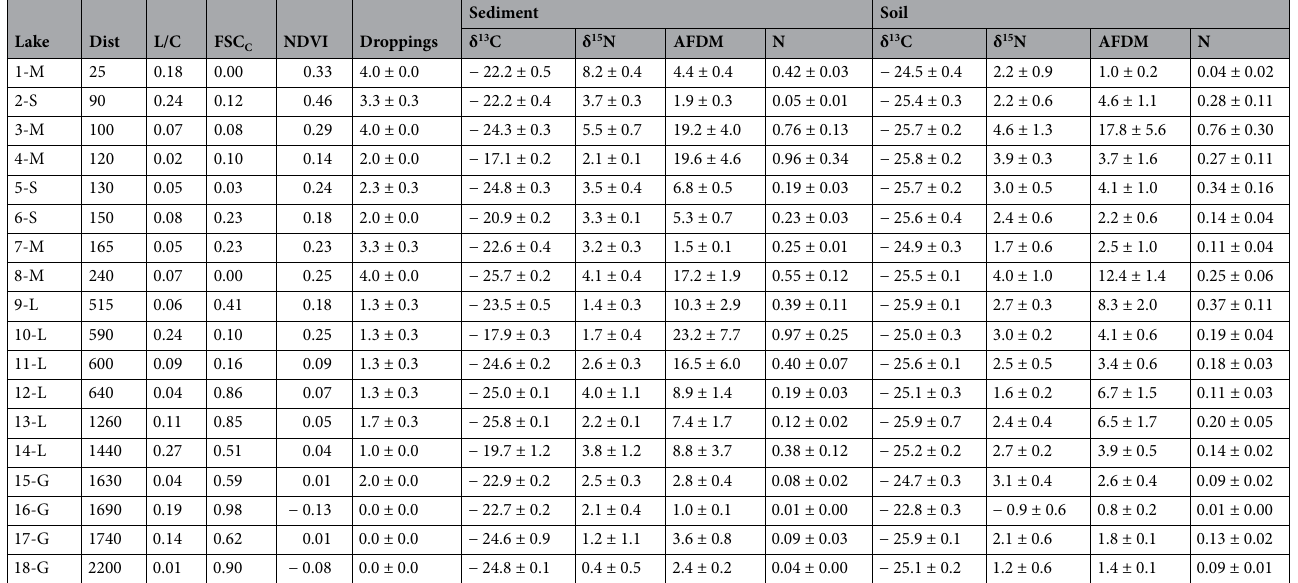
Table 1. Mean (± standard error) δ 13 C (‰), δ 15 N (‰), ash free dry matter (AFDM, %) and N content (%) in the sediments of 18 shallow Arctic lakes and soil in their catchment areas in North Spitzbergen (Svalbard Islands). “Dist.”: distance from the centre of the lake to the coast (m), “L/C”: ratio of lake to catchment surface area, “FSC C ”: fraction of snow coverage in the catchment area at the beginning of summer (June), “NDVI”: mean NDVI during summer (i.e. from June to August), “Droppings”: relative amount of goose droppings, ranging from 0 (absent) to 4 (very high). Lakes are numbered according to increasing distance from the coast and capital letters indicate lake category: M: “ muddy coastal ”; S: “ sandy coastal ”; L: “ lowland ”; G: “ glacier